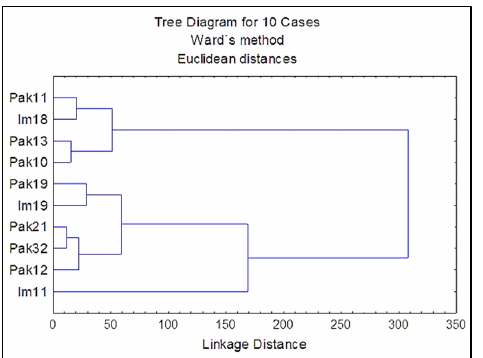
Figure 4. Ward’s dendrogram of V. sylvestris genotypes constructed based on the Euclidean distance matrix from six studied morphological characteristics of pollen grains: polar axis (P), equatorial axis (E), P/E ratio, number of exine perforations, perforation width and perforation length, in Statistica.